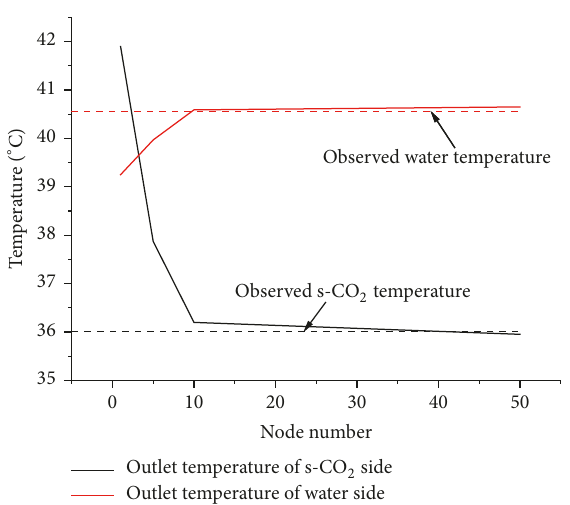
Figure 7: Mesh size sensitivity on outlet temperatureprediction for PCHE in case 6.